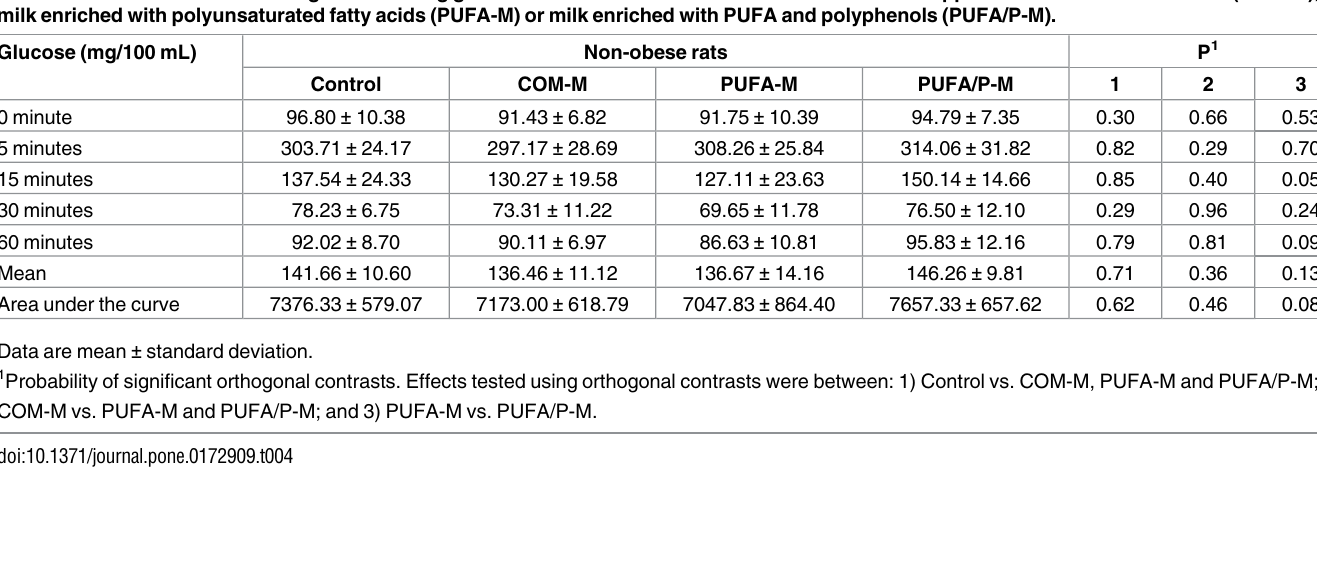
milk did not changed blood parameters, except for LDL-cholesterol which was decreased by PUFA/A-milk ( P = 0.08) (data not shown). Blood glucose values obtained during glucose tolerance test in non-obese rats are shown in Table 4. There was no difference in blood glucose between control rats and rats supplemented with common milk. PUFA/P-milk increased blood glucose at 15 minutes ( P = 0.05), and also tended to be increased at 60 minutes ( P = 0.09) and area under the curve ( P = 0.08), compared (data not shown).